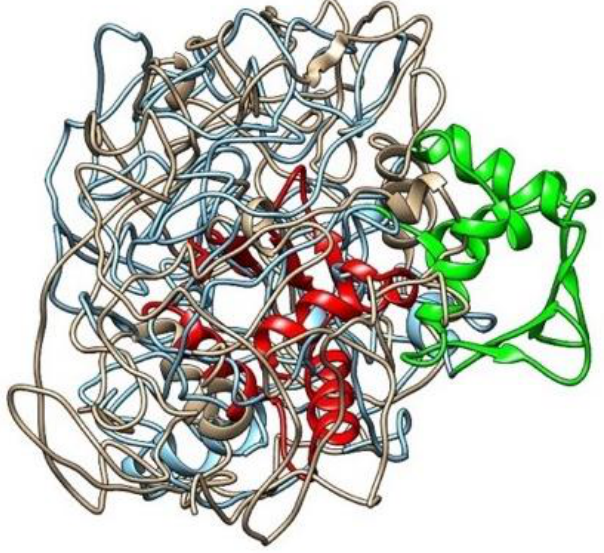
Figure 3. ERF structures were superimposed in UCSF Chimera and were found to be structurally dissimilar (RMSD across all pairs: 29.567 Å ).